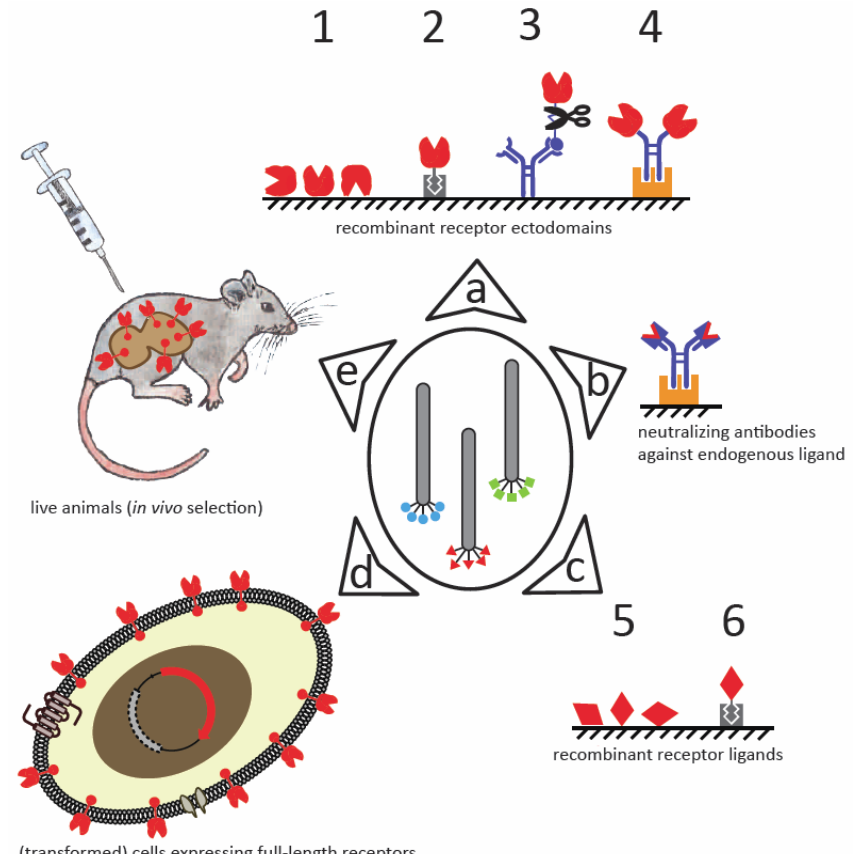
Figure 1. Schematic representation of some well-established biopanning approaches to identify membrane receptor-binding peptides from phage-displayed libraries. (a) Due to the difficulties accompanying isolation and recombinant expression of whole membrane receptors, only the extracellular regions (shown in red) or their individual domains can be used as target molecules. These can be immobilized to an appropriate matrix (oblique striped grounding) by direct adsorption (1) or by a suitable affinity tag that is recognized by its respective binding partner (e.g., biotin-avidin interaction, 2) or a specific antibody (3). A linker connecting the affinity tag to the receptor fragment that contains a specific protease cleavage site (3) can be introduced to facilitate the specific elution of target-bound phages by protease treatment. Alternatively, receptors may be imitated by recombinant antibody chimeras (receptor ectodomains fused to the Fc-region of an antibody; 4), in which case the target molecule is specifically captured to protein A- or G-coated matrix (shown in orange). (b) Targeting neutralizing antibodies against the endogenous ligand can result in selection of peptides binding to cognate receptor. (c) The ligand-receptor interaction can be inhibited by targeting the endogenous ligand instead of the receptor. Again, direct (5) or indirect immobilization (6) of the ligand is possible. (d) A more advanced strategy is to screen against whole cells over-expressing the full-length membrane-embedded receptor; this is usually achieved by transforming cells with a gene encoding the receptor. (e) In the in vivo approach, library phages are injected intravenously into an animal, and specific binders are recovered from tissue biopsies. The identities of the targeted receptors are determined